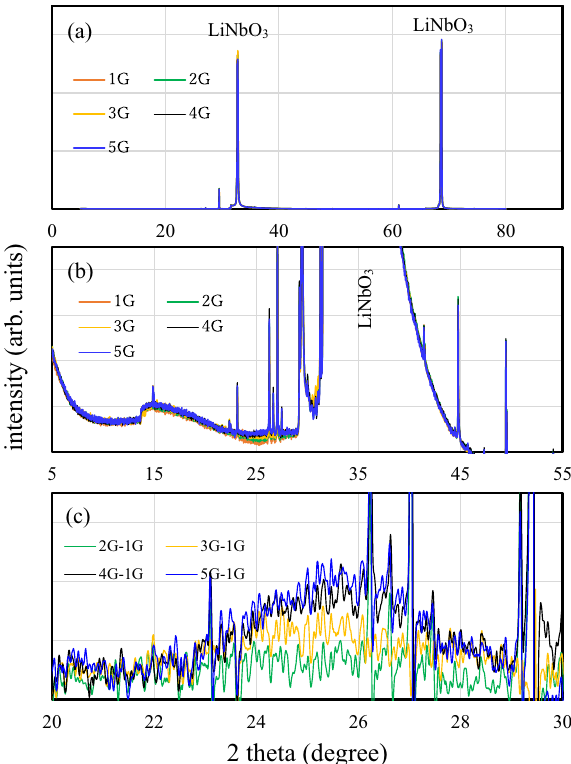
Figure 1. ( a ) X-ray diffraction patterns of mono-, bi-, tri-, tetra-, and penta-layer graphene/LiNbO 3 structures with 2θ between 5° and 85°. ( b ) An enlarged view of the X-ray diffraction patterns of mono-, bi-, tri-, tetra-, and penta-layer graphene/LiNbO 3 structures with 2θ between 5° and 55°. ( c ) Differences between the diffraction intensities of bi-, tri-, tetra-, and penta-layers and those of mono-layer sample with 2θ between 20° and